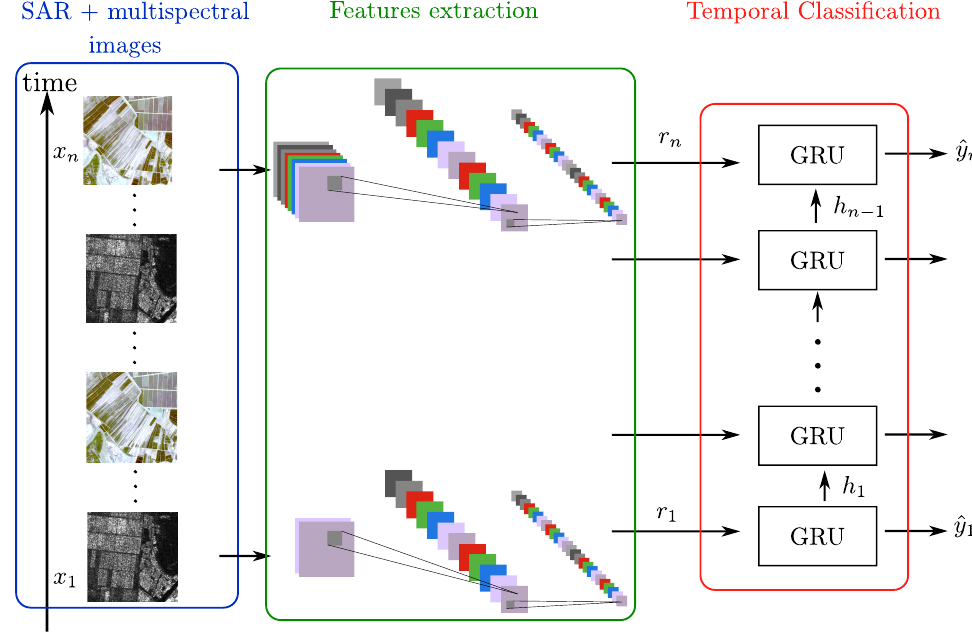
Figure 3. The proposed pipeline for flood detection in sequences of remote sensing images.